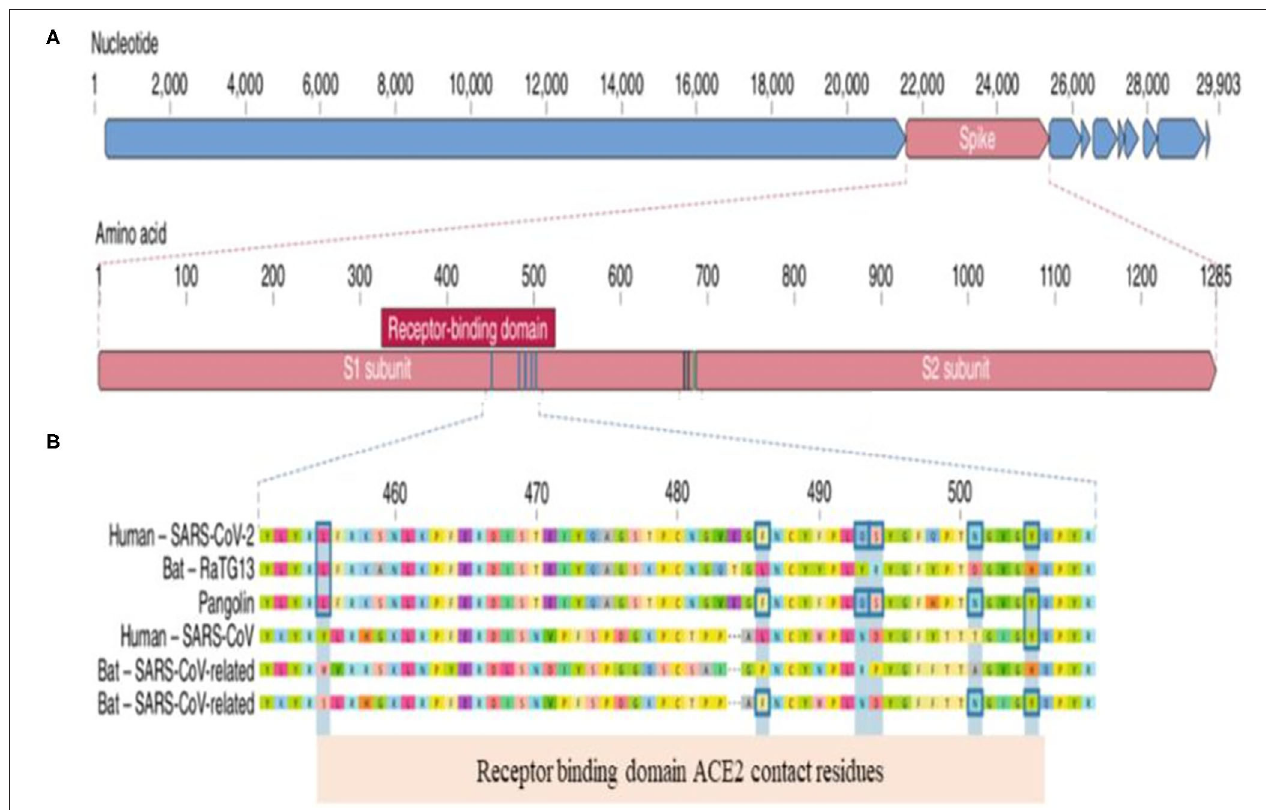
FIGURE 1 | Genomic Landscape of SARS-CoV-2 Virus. (A) The receptor binding domain (RBD) in the spike protein is the most varibale part of the genome. Six amino acids have been shown to be pivotal for binding to ACE2 receptors. Key residues in the spike protein that make contact to ACE2 receptor are shown with blue boxes. (B) Polybasic cleavage site (PRAR) at the junction of S1 and S2 subunit is a relevant feature of the viral genome. This allows effective cleavage by furin and other proteases and has a role in determining viral infectivity (3).